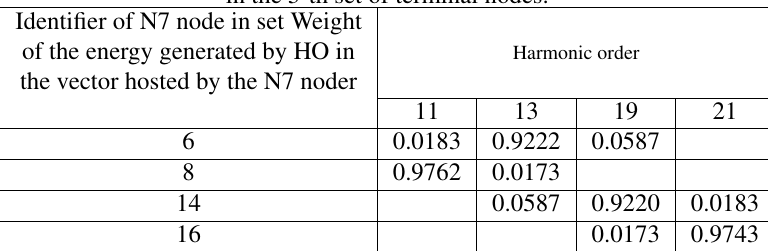
Table 2. Weights of the energies generated by the harmonics in the 5-th set of terminal nodes.